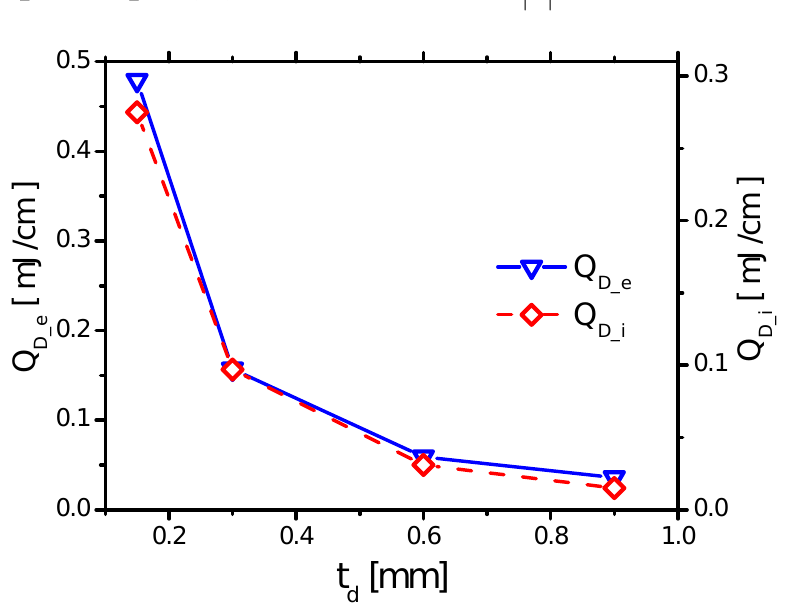
Figure 28. The effects of t d on the electrons’ energy Q D _ e and the ion’s energy Q D _ i in Case 1 and Cases